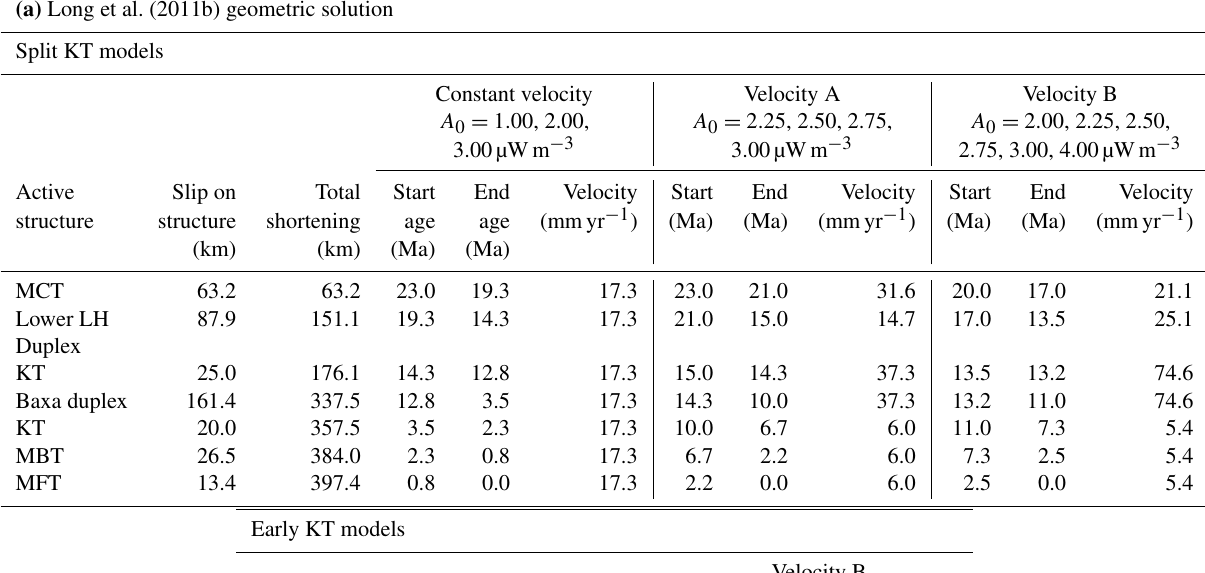
Table 3. Combinations of heat production values, deformation ages, and rates tested for each flexural–kinematic model. (a) Long et al. (2011b) geometric